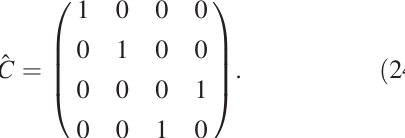
. Finally, we begin measuring